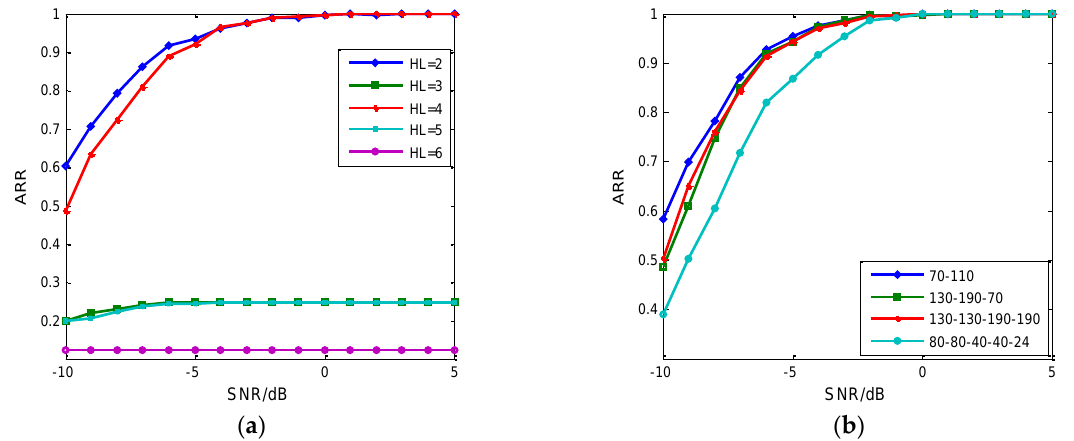
Figure 10. ARR of different hidden layers. ( a ) Each hidden layer has 200 nodes in RDBN; ( b ) each hidden layer has the tuned nodes in RDBN.